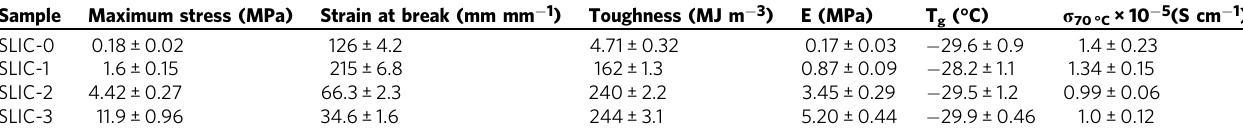
Fig. 3 Characterization of SLIC as a polymer electrolyte. All samples contain 20 wt.% LiTFSI. a Ionic conductivity of plasticized and neat SLIC electrolytes as a function of UPy content in the polymer backbone. Measurement temperature is 25 °C. No SiO 2 is present in these samples. b Ionic conductivity versus T g -shifted temperature for plasticized SLIC electrolytes with 20 wt.% LiTFSI, 20 wt.% DEGDME, and no SiO 2 . The orange dashed line serves to guide the eye. c 7 Li NMR traces of the SLIC electrolytes dissolved in CDCl 3 with 20 wt.% LiTFSI in each sample. d Stress-strain curves of plasticized SLIC-3 electrolytes with and without 2 wt.% SiO 2 . The strain rate is 100 mm/min e Normalized ionic conductivity as a function of strain for the SLIC electrolyte. This electrolyte incorporates SLIC-3 with 20 wt.% LiTFSI, 20 wt.% DEGDME, and 2 wt.% SiO 2 . Inset shows a schematic of the measurement apparatus f Comparison of the toughness and ionic conductivity of SLIC electrolytes to other electrolytes reported in literature. Details of comparison are included in the Supplementary Information. Table 1 Mechanical properties of the plasticizer-free SLIC electrolytes with 20 wt.% LiTFSI along with the glass transition temperature (T g ) and ionic conductivity ( σ ) of the samples at 70 °C. The young ’ s modulus is labeled as E. Sample Maximum stress